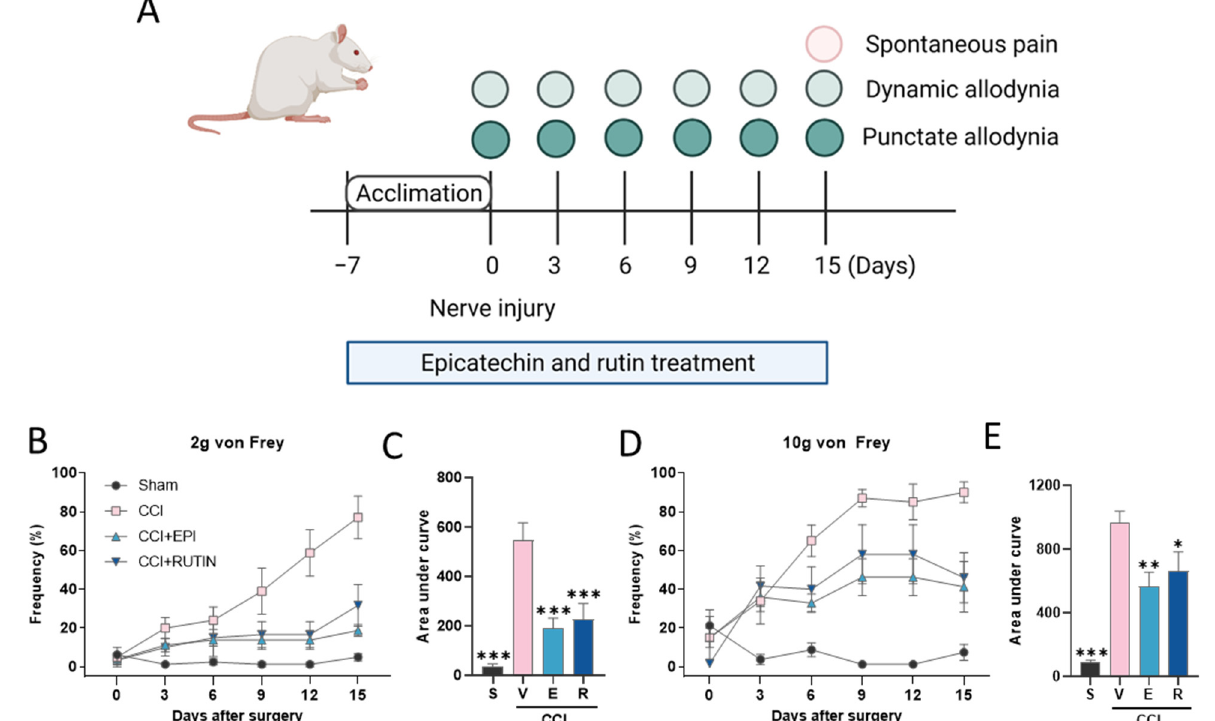
Figure 3. Effect of oral administration of ( − )-epicatechin and rutin on pain sensitivity in a chronic constriction injury (CCI) model. ( A ) Experimental scheme of the pain-associated behavior test. Punctate allodynia was measured using a von Frey filament. The paw withdrawal frequency under 2 ( B , C ) and 10 g ( D , E ) von Frey filament stimulations. ( F , G ) The mechanical withdrawal threshold (MWT) was measured using the von Frey filament test. The area under the curve values for the paw withdrawal frequency under 2 ( C ) and 10 g ( E ) von Frey filament stimulations, and the MWT ( G ). Dynamic allodynia was elicited using a dynamic brush test ( H , I ) and cotton wisp ( J , K ). The area under the curve values for the dynamic brush test ( I ) and cotton wisp ( K ). ( L ) Spontaneous pain scores 15 days after CCI surgery. Black dots, red rectangles, blue triangles and gray triangles repre- sent sham, CCI with the vehicle, CCI with ( − )-epicatechin, and CCI with rutin, respectively. Data